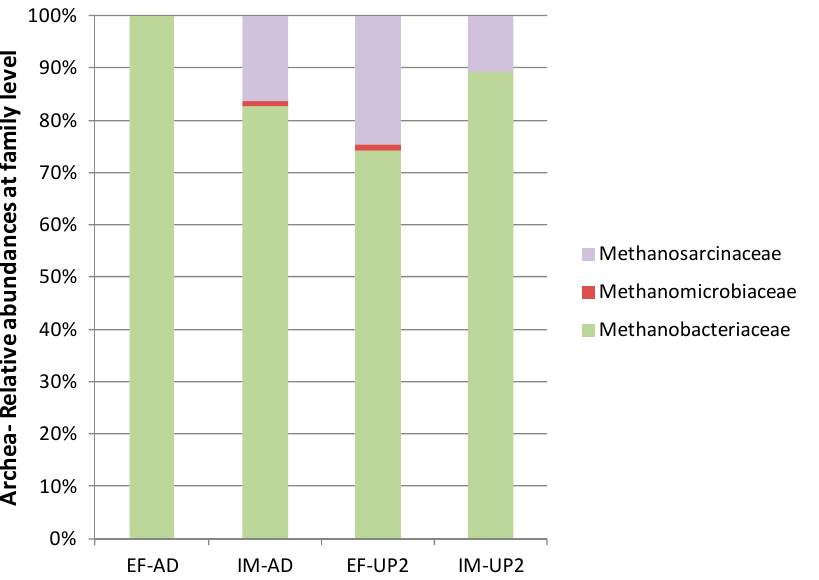
Figure 6. Relative abundances of the archaea community at the family level at the end of AD (anaerobic digestion) and UP2 (H 2 injection) phases. Communities with a relative abundance ≥ 0.5% (in at least one sample) are reported. EF, effluent and IM, interstitial matrix.